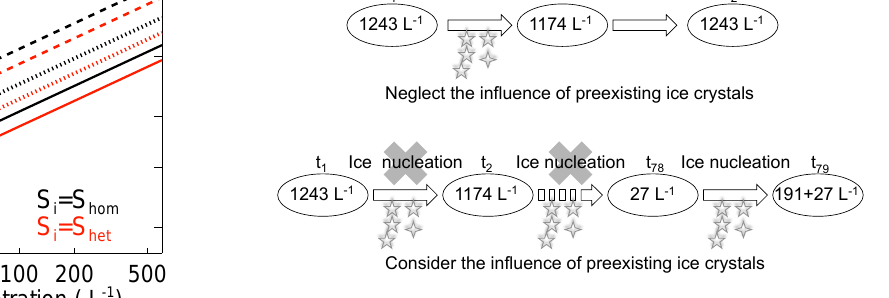
Figure 2. Schematic diagram of cirrus cloud evolution. Upper panel represents the default ice nucleation scheme that neglects the influ- ence of PREICE; lower panel represents the updated scheme that considers the PREICE effect. Ice crystal number concentrations are shown inside the ovals. Time steps are shown above the ovals. All numbers are based on cirrus cloud evolution within a model grid cell (3 ◦ N, 75 ◦ W, ∼ 198hPa, ∼ 217K). In this experiment, the up- draft velocity is set to 0.2ms − 1 and the sulfate number concen- tration is set to 100cm − 3 . Heterogeneous nucleation is not taken into account. The simulation is run 3 months. Just one cirrus cloud evolution process is shown